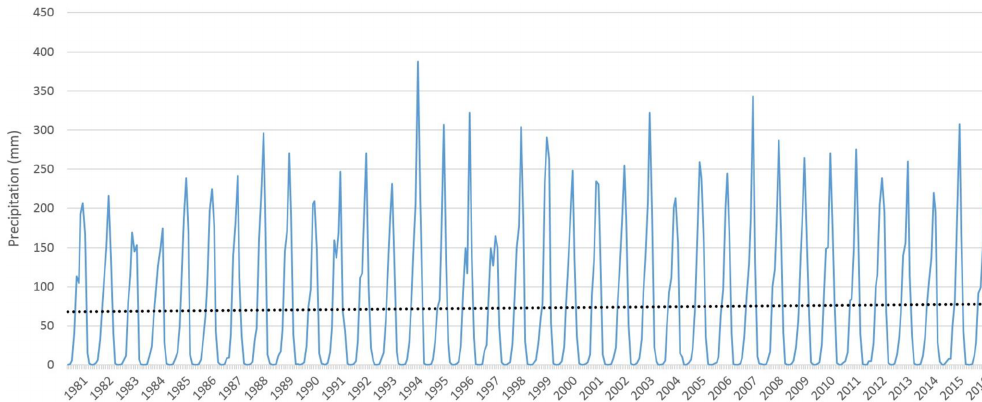
Figure 3. Temporal monthly precipitation profile for the Mékrou area of interest.